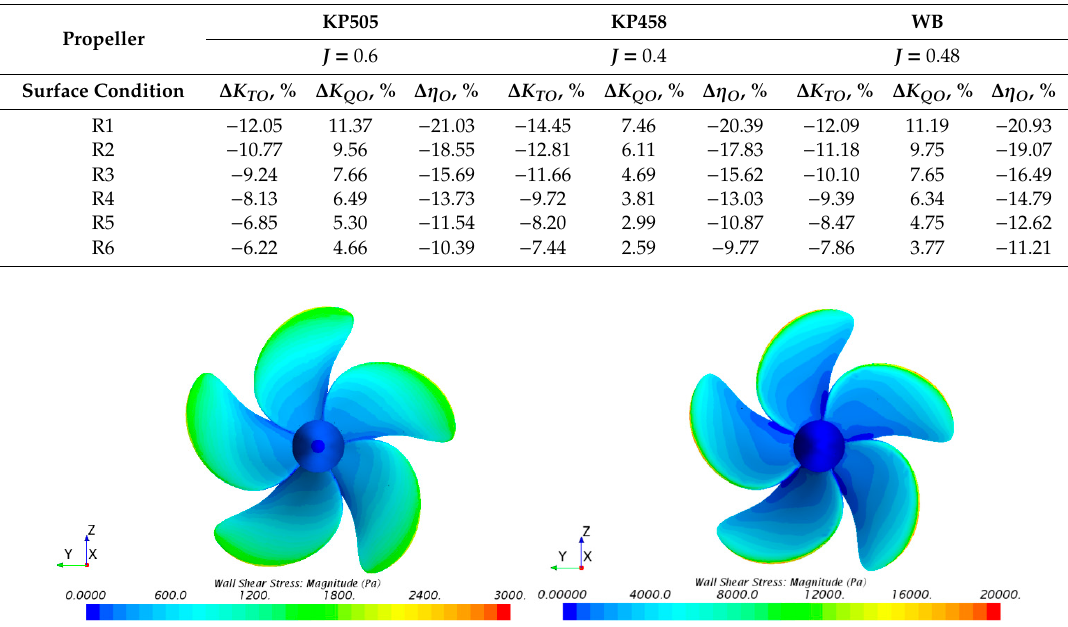
τ distribution for smooth ( left ) and R1 ( right ) surface condition for Figure 11. The obtained Figure 11. The obtained τ w distribution for smooth ( left ) and R1 ( right ) surface condition for w KP505.